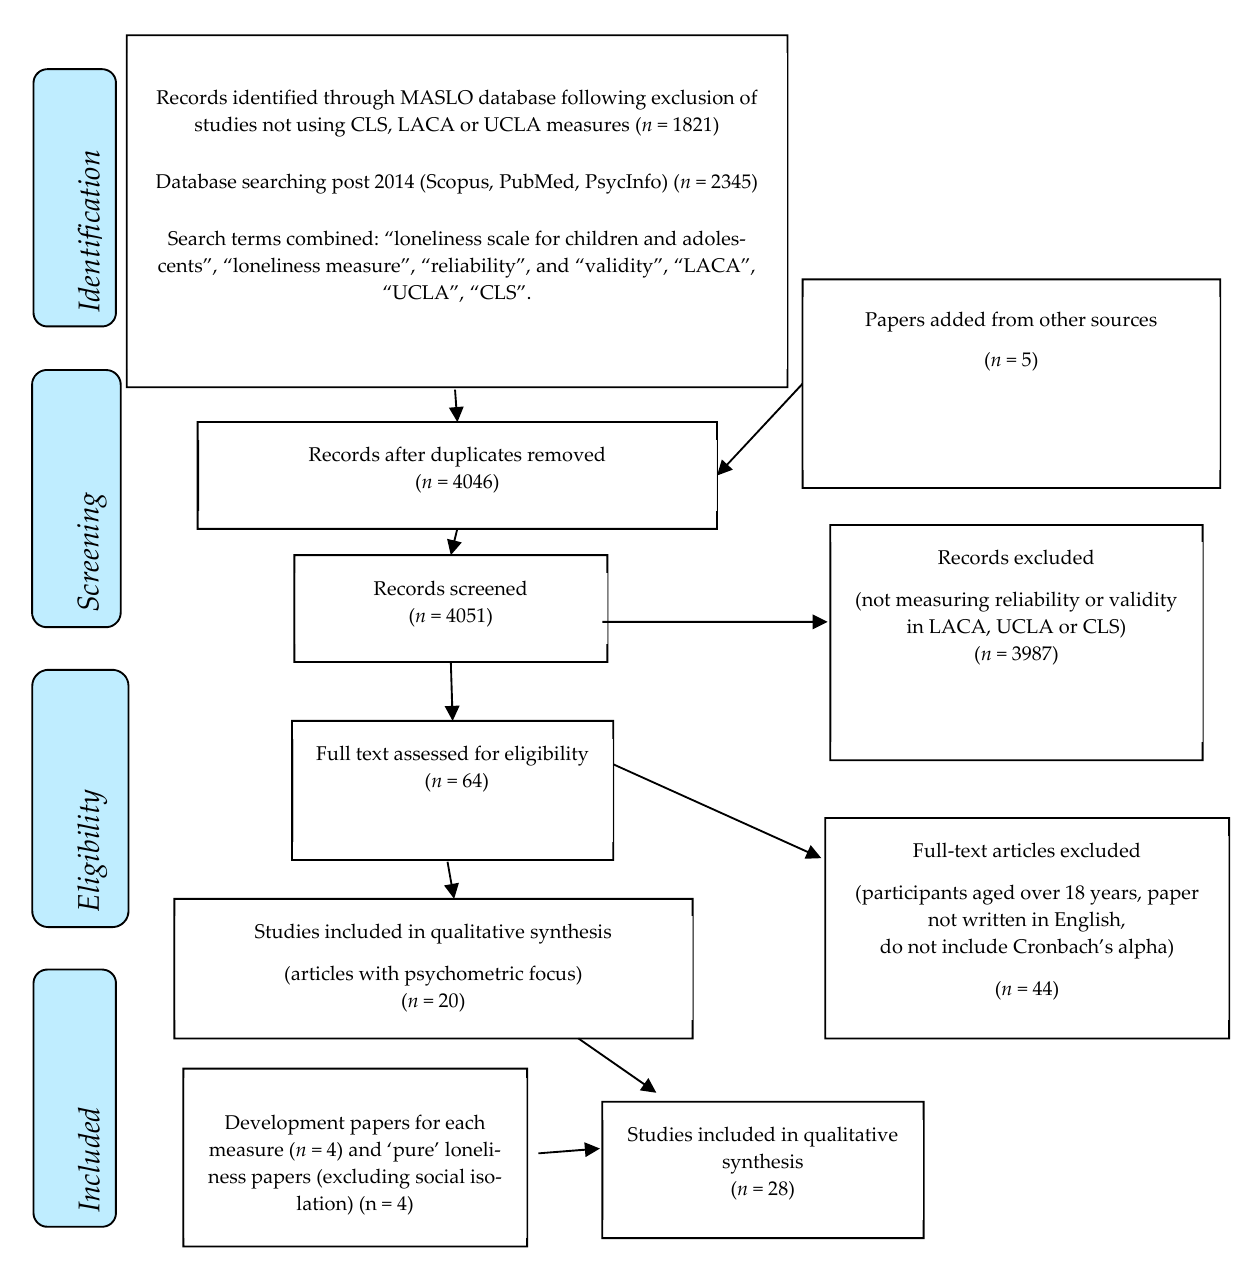
Figure 1. PRISMA diagram [21].